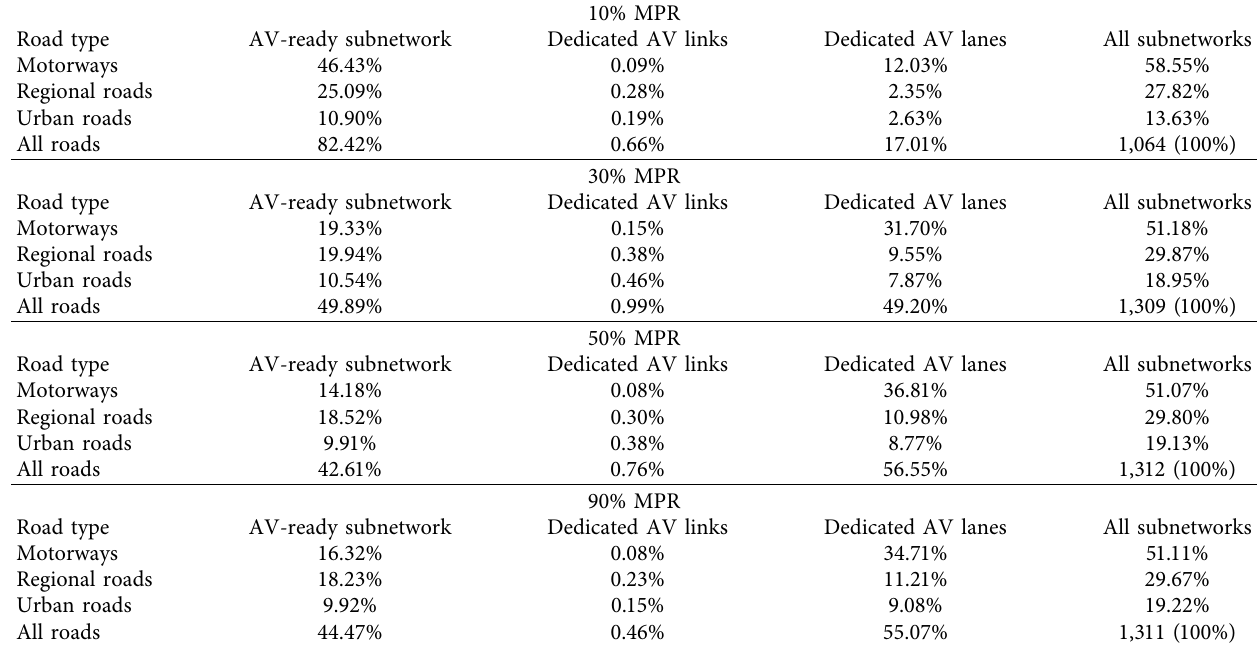
Table 6: Distance coverage of each subnetwork (km) in each road type. 10%